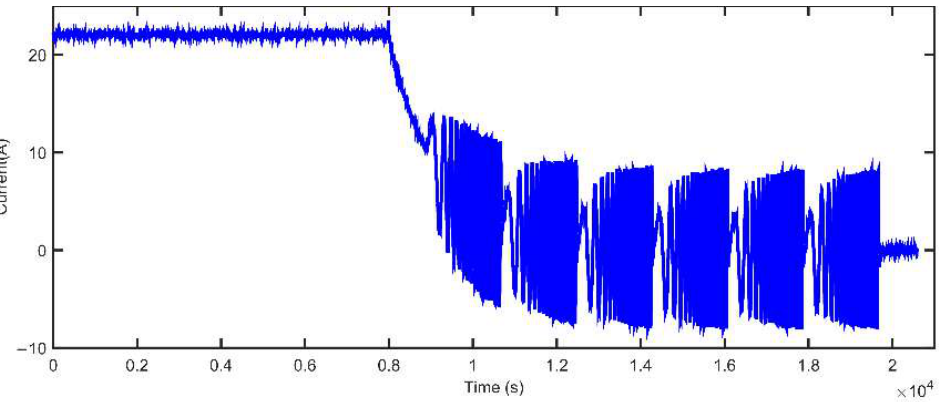
Figure 22. Dynamic condition test 3 experimental current.